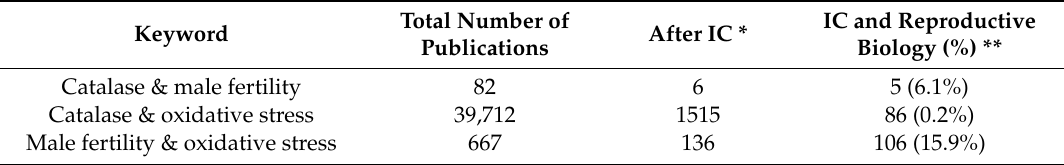
Table 2. Number of publications included in the database for this work (articles identified after the Web of Science search) before and after applying the inclusion criteria and framed within the reproductive biology research